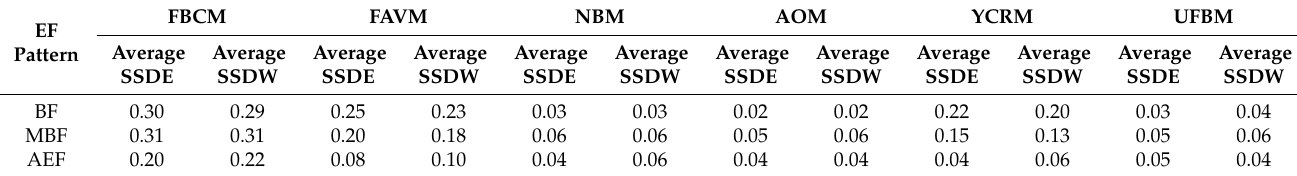
Table 3. Average SSDE and SSDW obtained by the six conflict-resolution methods according to different GCMs for each EF